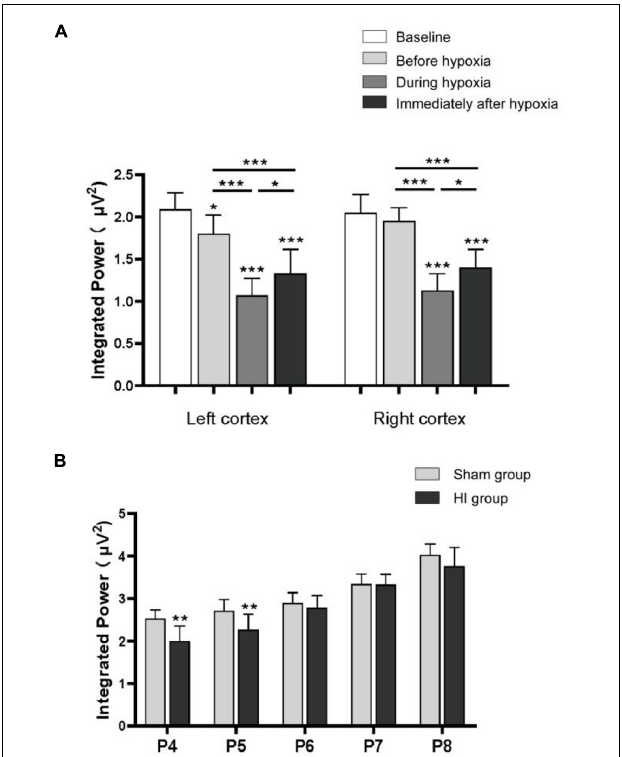
FIGURE 6 | Integrated power of background electroencephalography (EEG). The integrated power analysis in the P3 rats of the hypoxia–ischemia (HI) group during the baseline, after left carotid ligation, but before hypoxia, during hypoxia, and immediately after HI (A) . The integrated power of the left cortex decreased compared with the baseline after the ligation of the left carotid artery. The power decreased significantly during hypoxia and immediately after hypoxia in both sides of the cortex. Integrated power value analysis from rat pups every day between P4 and P8 in HI and sham group (B) . The integrated power value returned to normal with the increase of time after hypoxia in the HI group compared with the sham group. All EEG epochs were acquired in the neonatal rats during quiet state to minimize the artifact. * p < 0.05; ** p < 0.01; *** p <